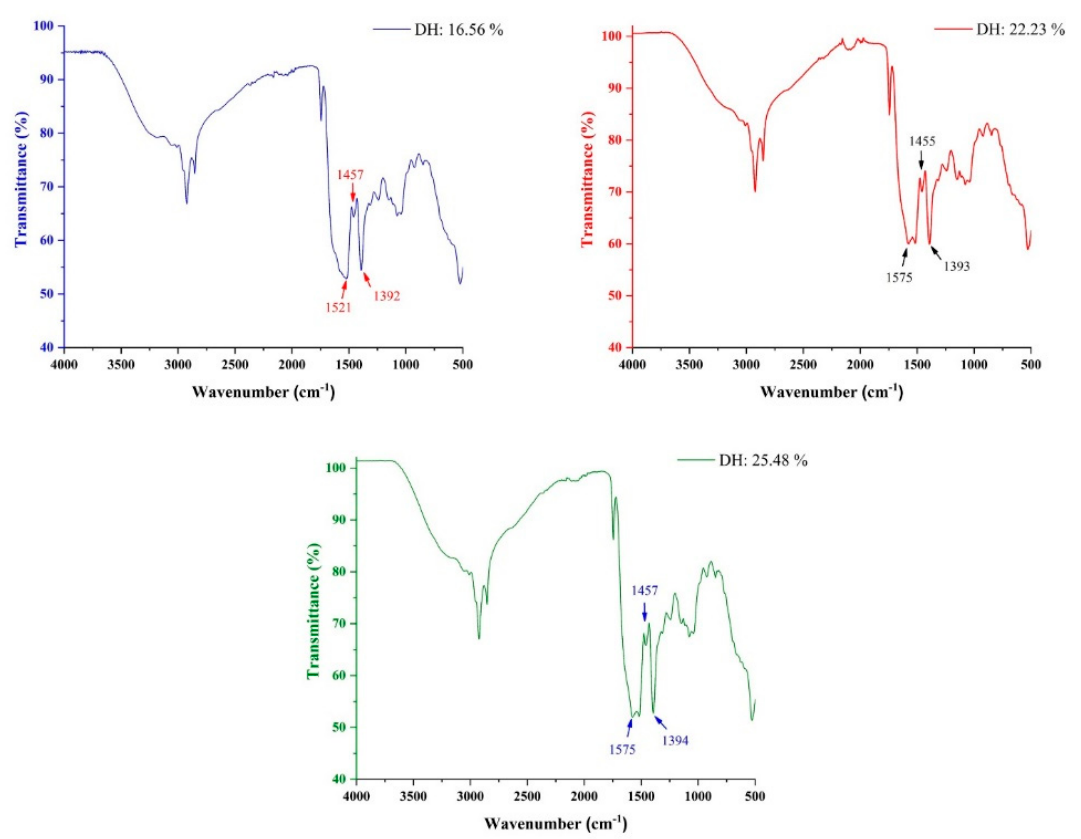
Figure 5. FTIR spectrum of FPH obtained at different degrees of hydrolysis using the flavourzyme enzyme. The various values on the graphs indicate the changes in amide bands I, II, and III.